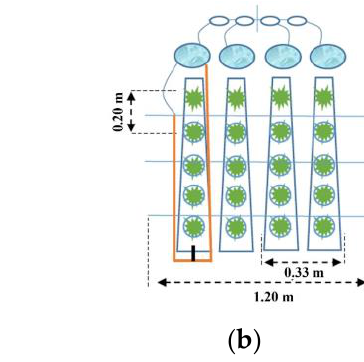
Figure 2. Arrangement of the plants in the hydroponic system.